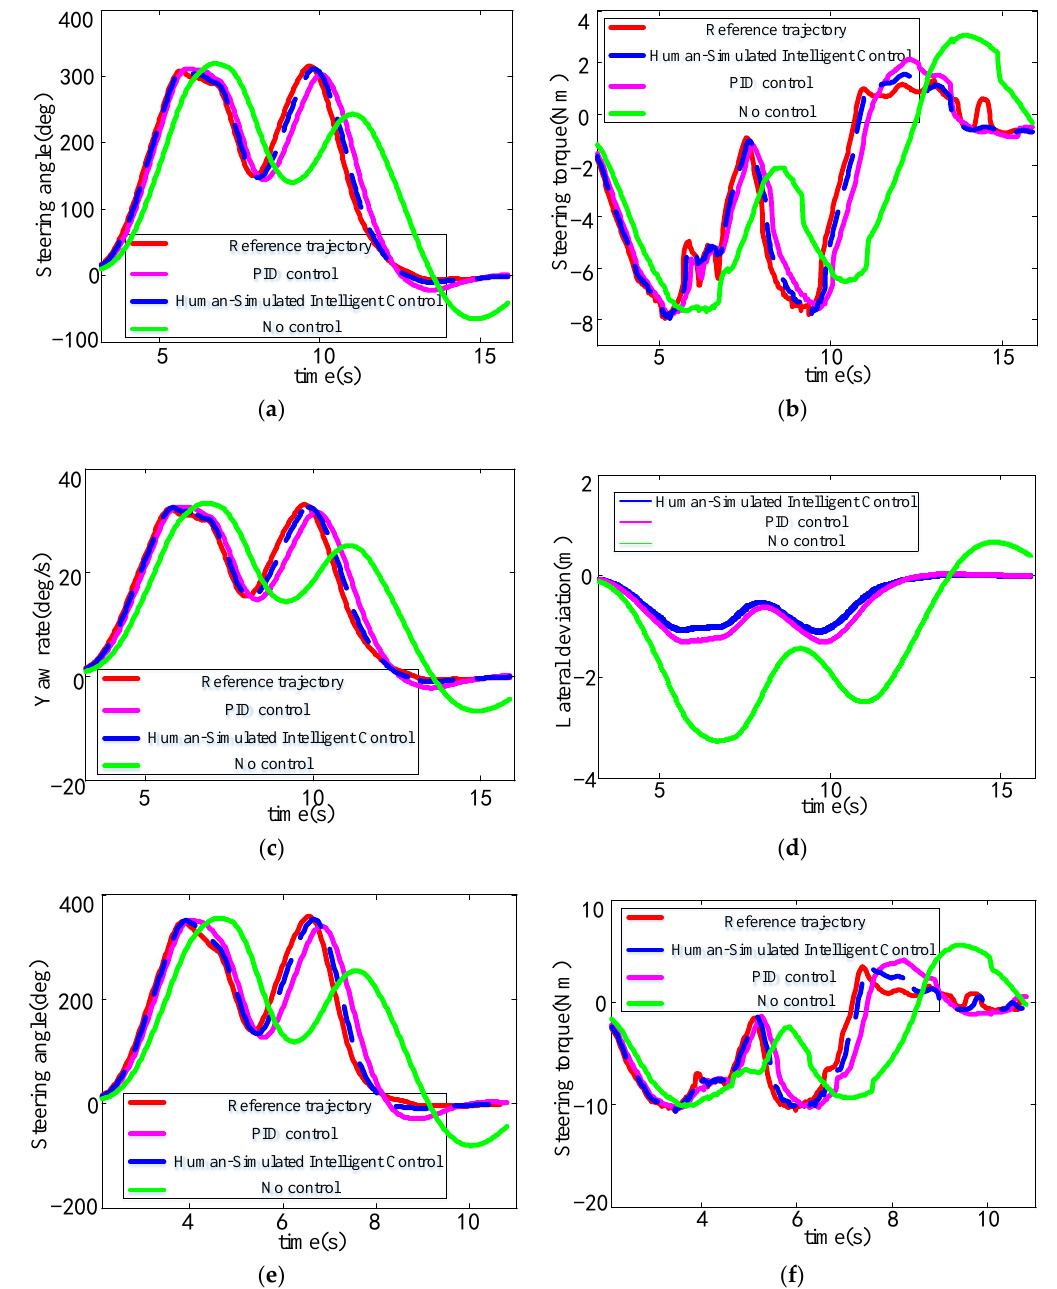
Figure 9. Comparison and analysis of control results under U-turn condition: ( a ) 20 km/h, comparison of steering wheel angle; ( b ) 20 km/h, comparison of steering wheel torque; ( c ) 20 km/h, comparison of yaw rate; ( d ) 20 km/h, comparison of lateral deviation; ( e ) 30 km/h, comparison of steering wheel angle; ( f ) 30 km/h, comparison of steering wheel torque.